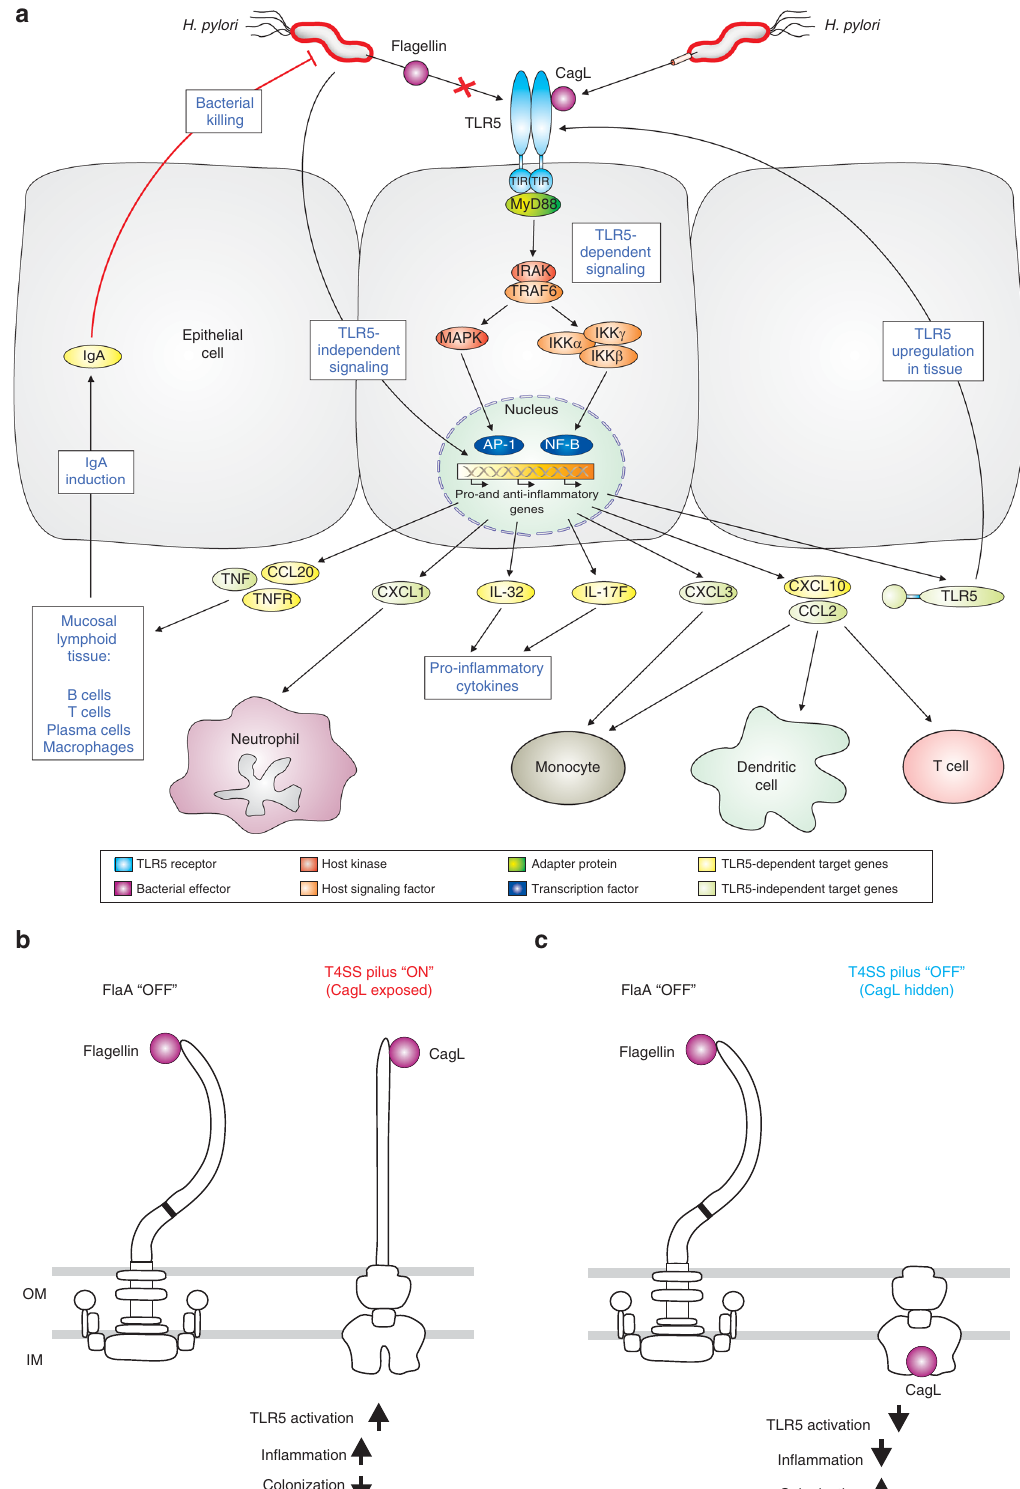
Functional classi fi cation of differentially expressed genes . DAVID (Database for Annotation, Visualization and Integrated Discovery) v6.8 tool was used to identify the differential expressed genes related to biological pathway or process by selecting Genetic Ontology term GOTERM_BP_FAT and KEGG pathway for functional clustering. The signi fi cant highly enriched (Highest stringency, EASE Score >2.0, p < 0.001) clusters among genes differentially expressed in H. pylori- infected TLR5 + (2/31 clusters) and parental cells (4/11 clusters), respectively, were identi fi